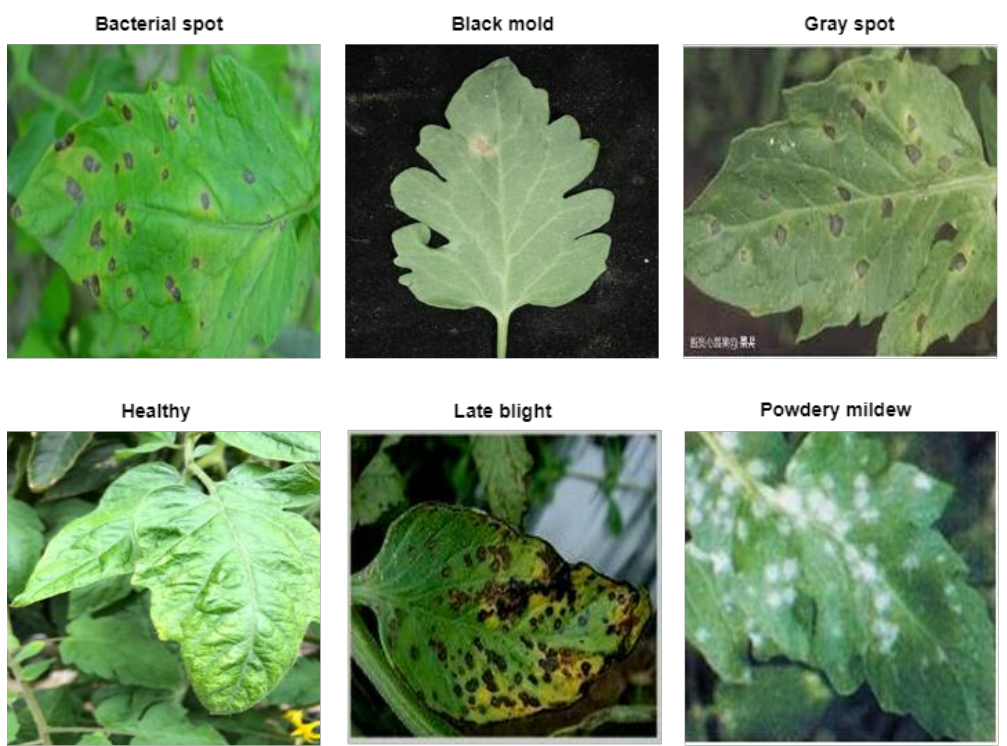
Figure 2. Sample of the second dataset used in the